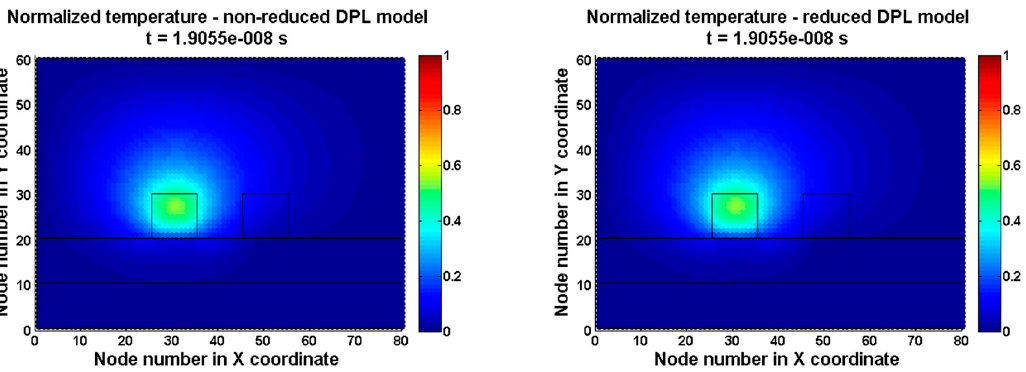
Figure 5. Comparison of normalized temperature rise in a cross-sectional area of the investigated MEMS structure obtained using reduced and non-reduced DPL model for t = 19.055 ns .